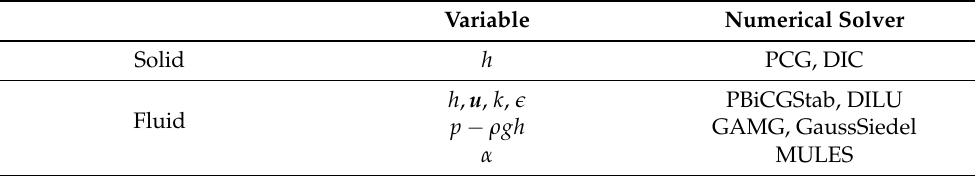
Table 2. Numerical solvers.